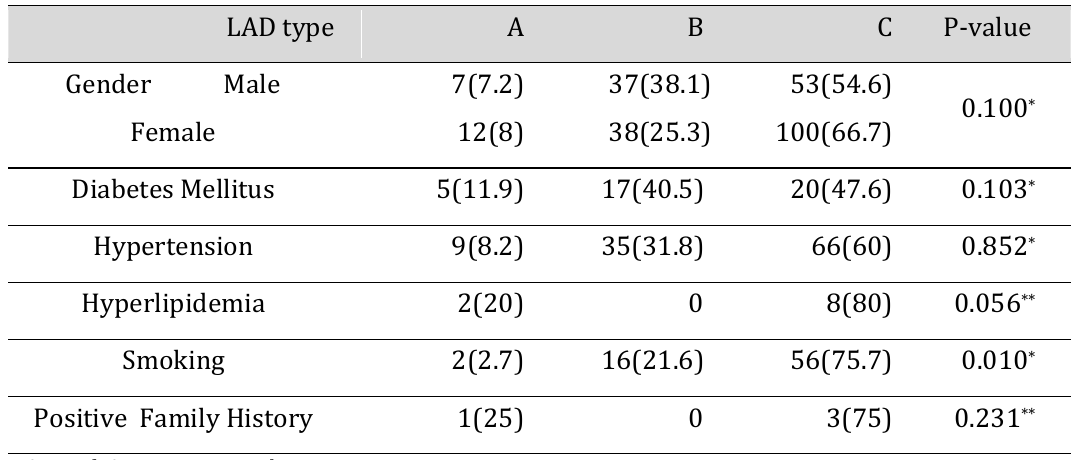
LAD: Left Anterior Descending * Chi-square test ** Fisher’s exact